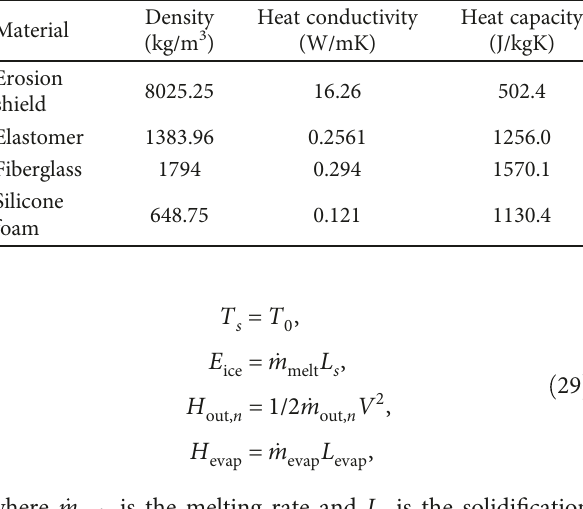
Figure 4: Material and structure of ice protection area. Table 2: Material properties of NASA